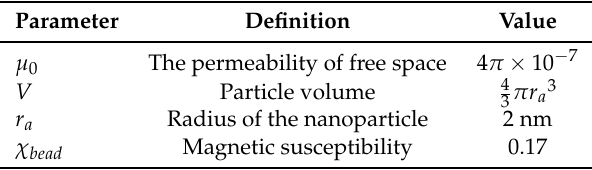
Table 3. Parameter definitions and values.